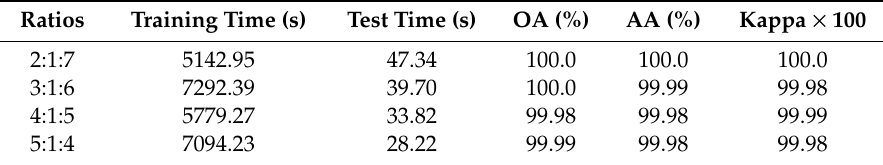
Table 9. Training time, test time, and OA under di ff erent ratios on the KSC dataset by the proposed